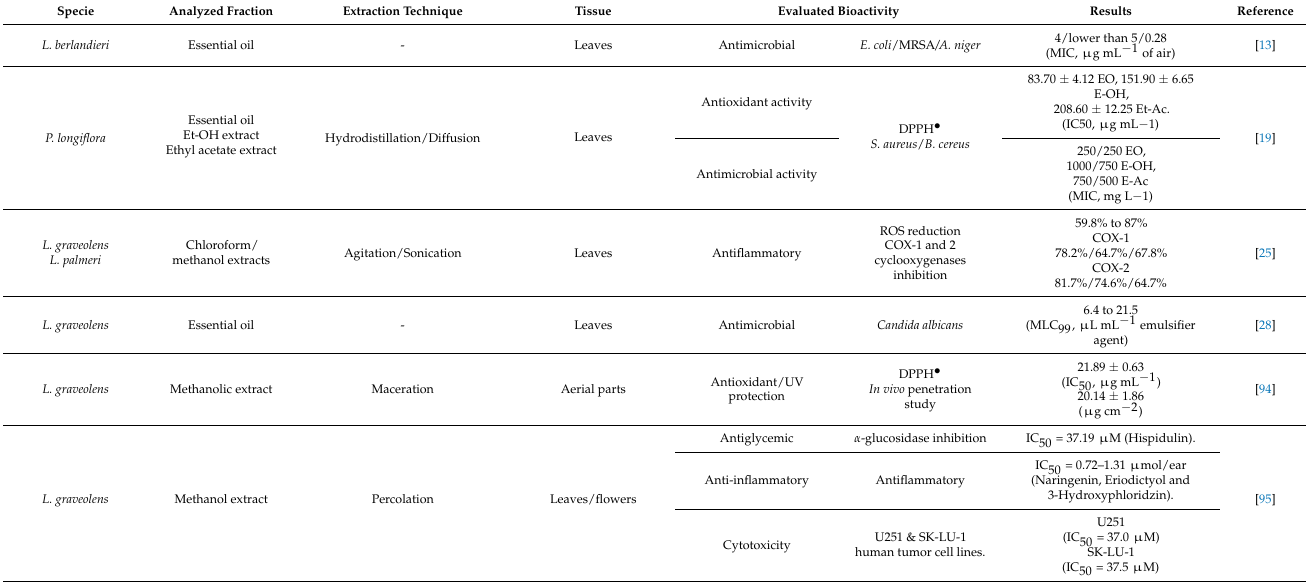
Table 2. Evaluations of the bioactive potential in Mexican